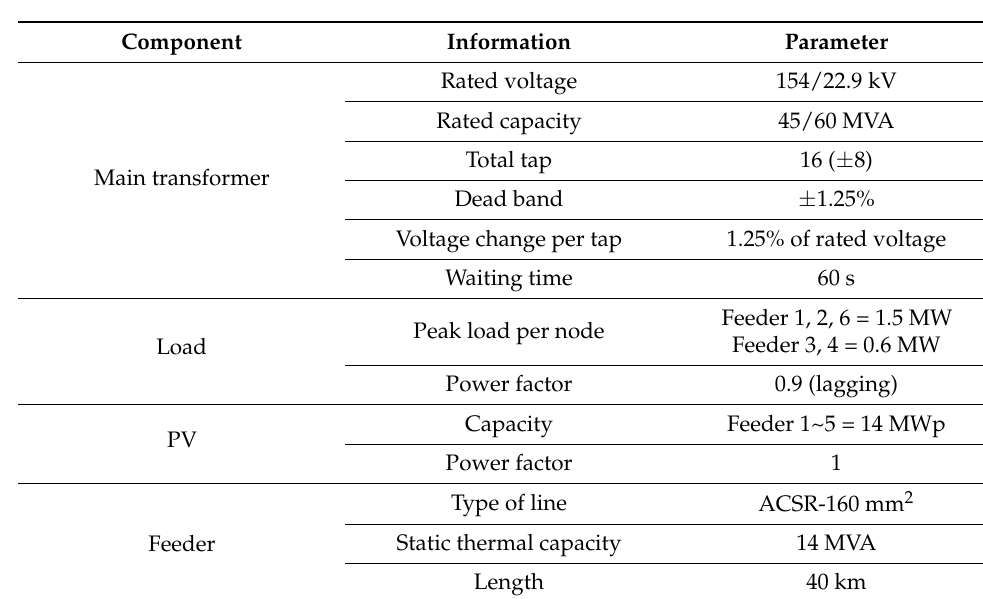
Figure 6. Test model of the MT with six feeders. Table 2. Parameters of the test